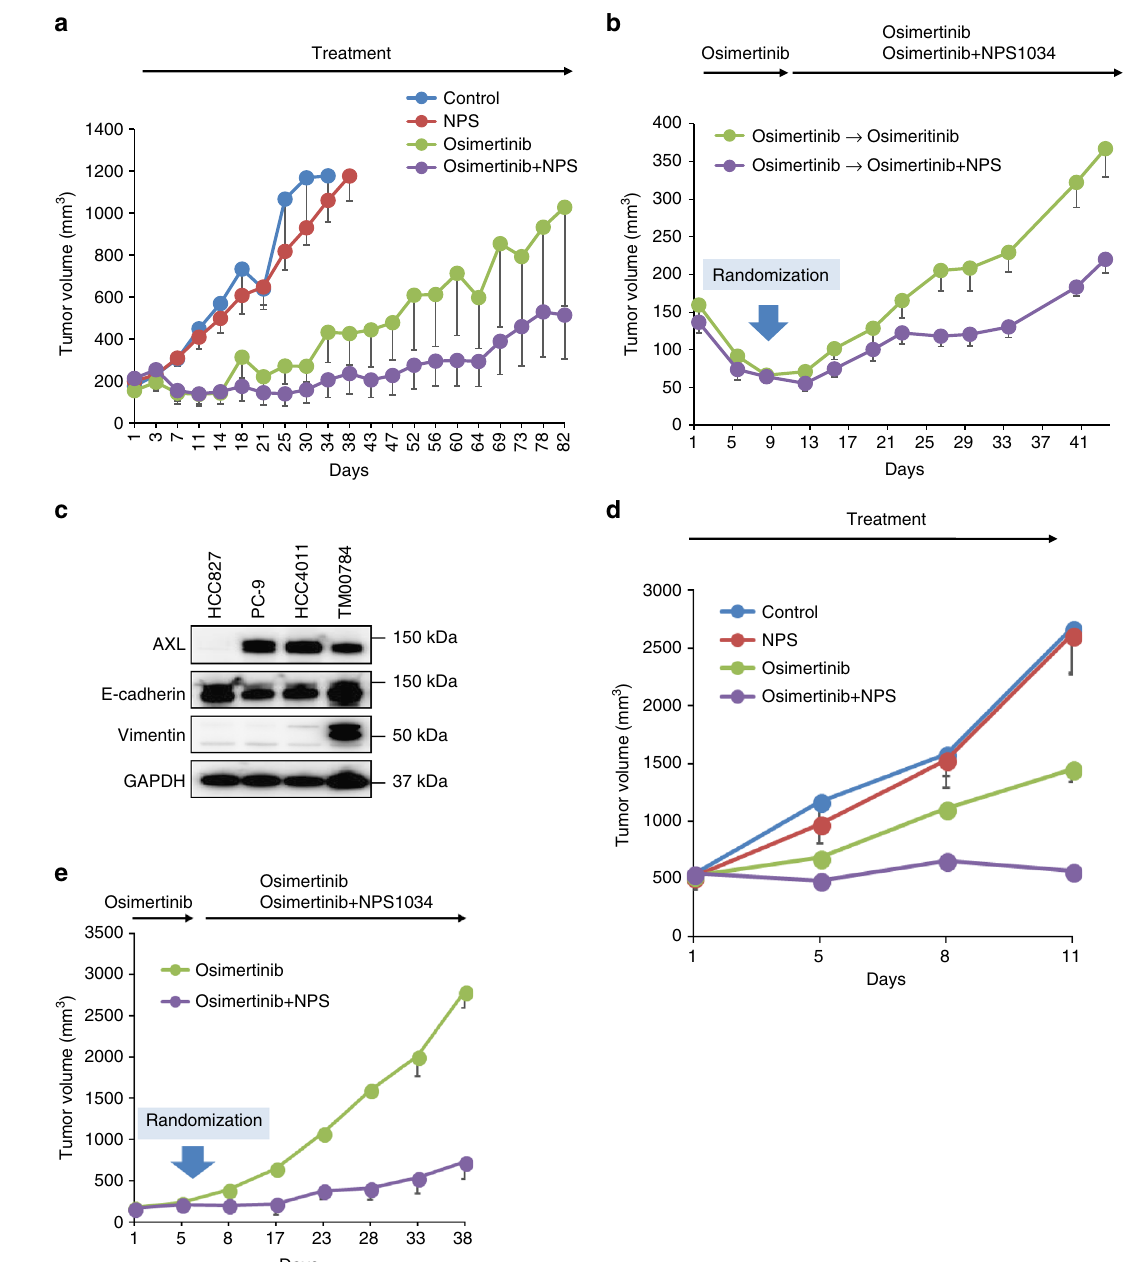
Fig. 7 AXL inhibitor with osimertinib inhibited growth of AXL-high tumors in vivo. a PC-9 cell-line-derived xenograft (CDX) tumors were treated with vehicle (control), NPS1034 50 mg/kg, osimertinib 5 mg/kg, or NPS1034 50 mg/kg plus osimertinib 5 mg/kg ( n = 6 each). Tumor volumes were measured over time from the start of treatment and the results are shown (mean ± SEM). b PC-9 CDX tumors were treated with osimertinib (5 mg/kg) for 8 days followed by the continuous administration of 5 mg/kg osimertinib or in combination with 50 mg/kg NPS1034 ( n = 7 each) administered. The results of tumor volume are plotted (mean ± SEM). c The indicated cells and patient-derived xenograft (PDX) tumors (TM00784) were lysed and the indicated proteins were detected by western blotting. d PDX tumors (TM00784) were untreated (control), treated with 50 mg/kg NPS1034, 5 mg/kg osimertinib, or a combination of 50 mg/kg NPS1034 and 5 mg/kg osimertinib ( n = 4 each). The results of tumor volume are plotted (mean ± SEM). e PDX tumors (TM00784) were treated with 5 mg/kg osimertinib for 7 days followed by continuous administration of 5 mg/kg osimertinib or in combination with 50 mg/kg NPS1034 ( n = 4 each). The results of tumor volume are plotted (mean ±